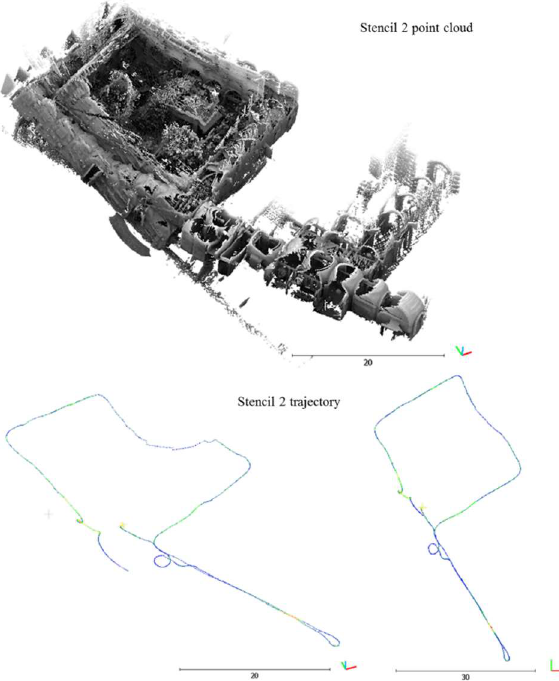
Table 2. Characteristics of the real-time solutions of the KAARTA Stencil 2.